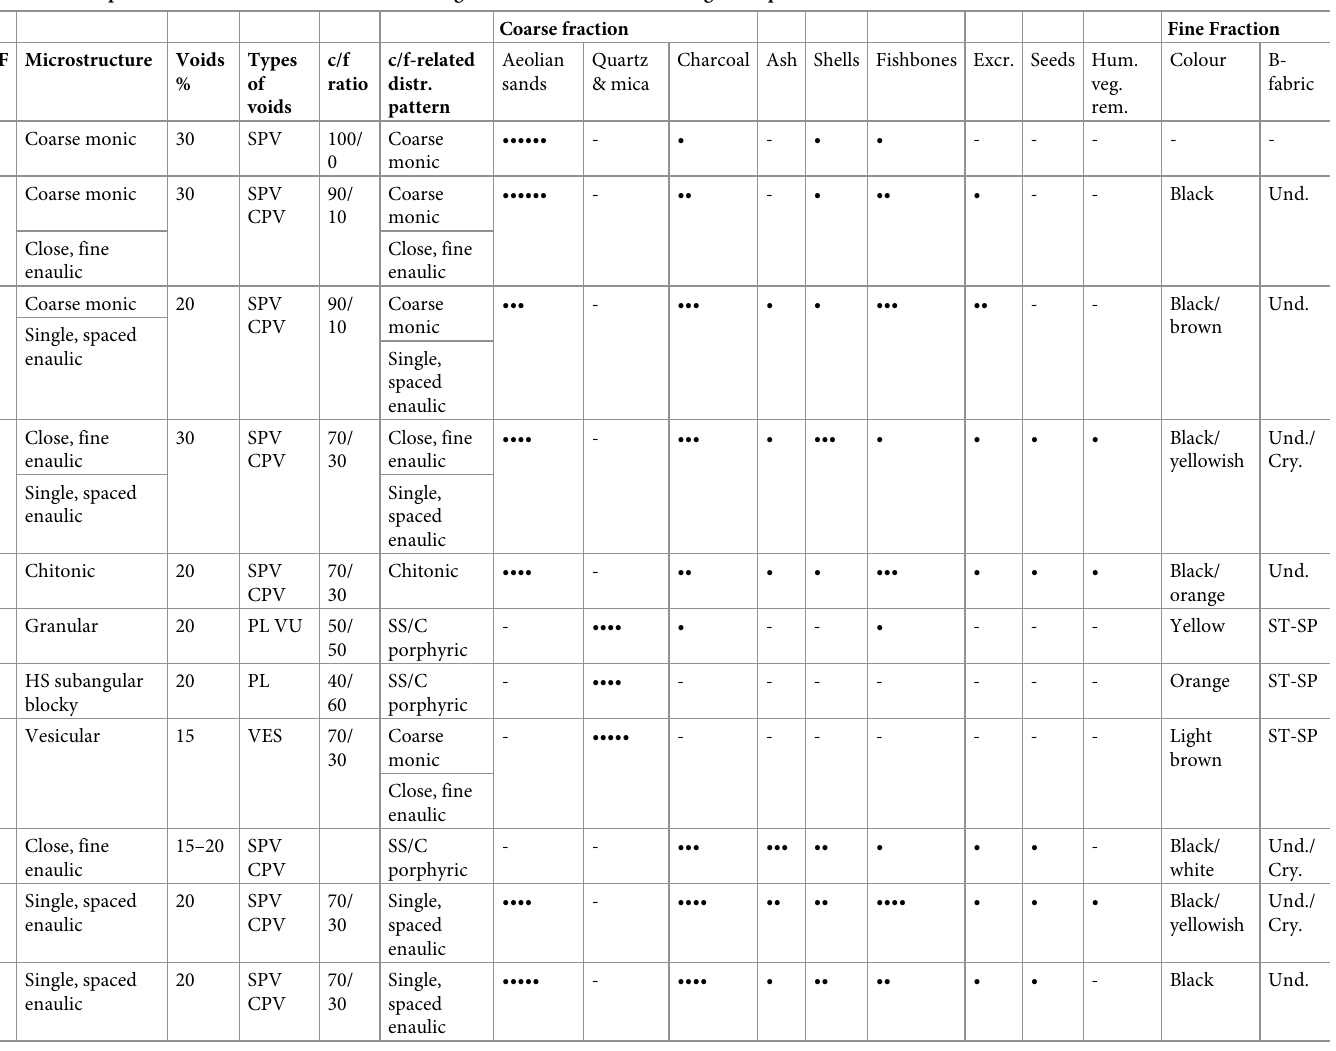
Table 1. Description of the 11 microfacies identified along the Huaca Grande archaeological